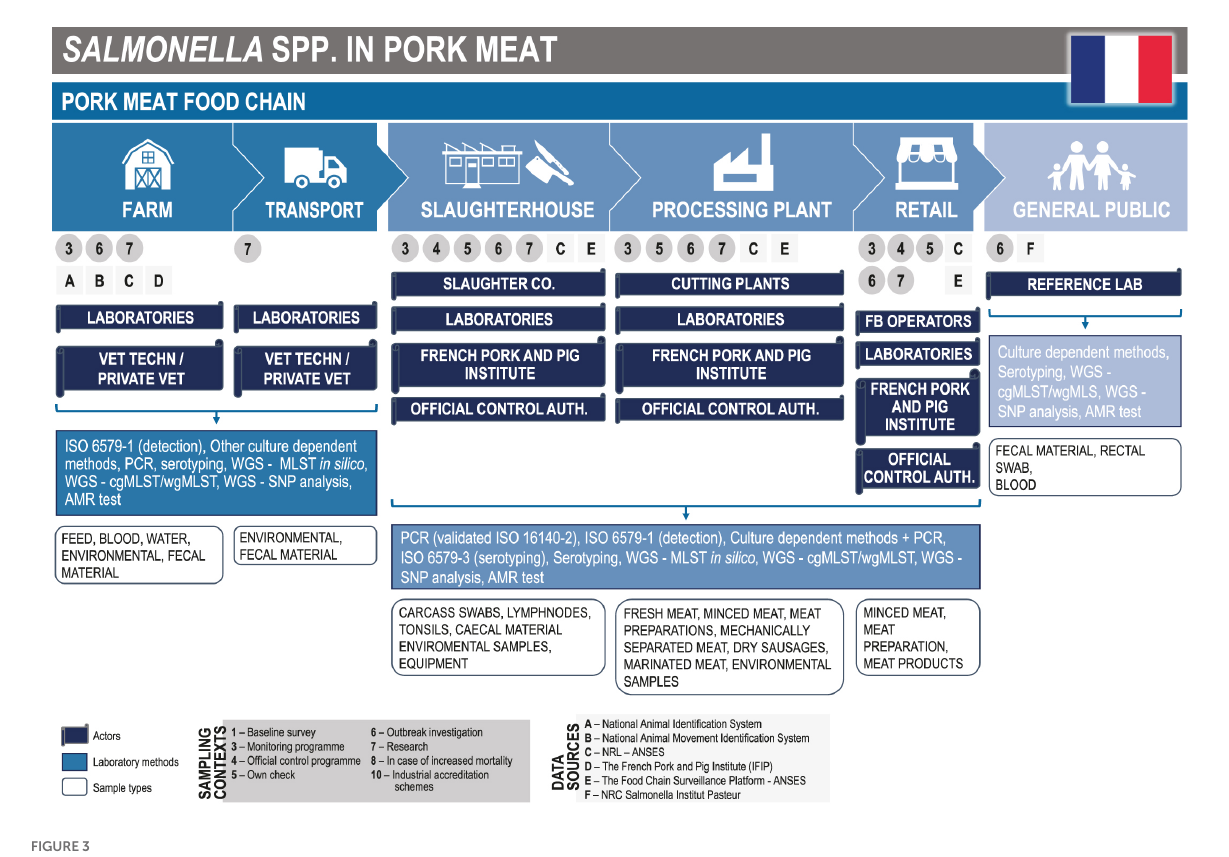
FIGURE 3 Salmonella mapping. Modified with permission from Cito et al., 2022